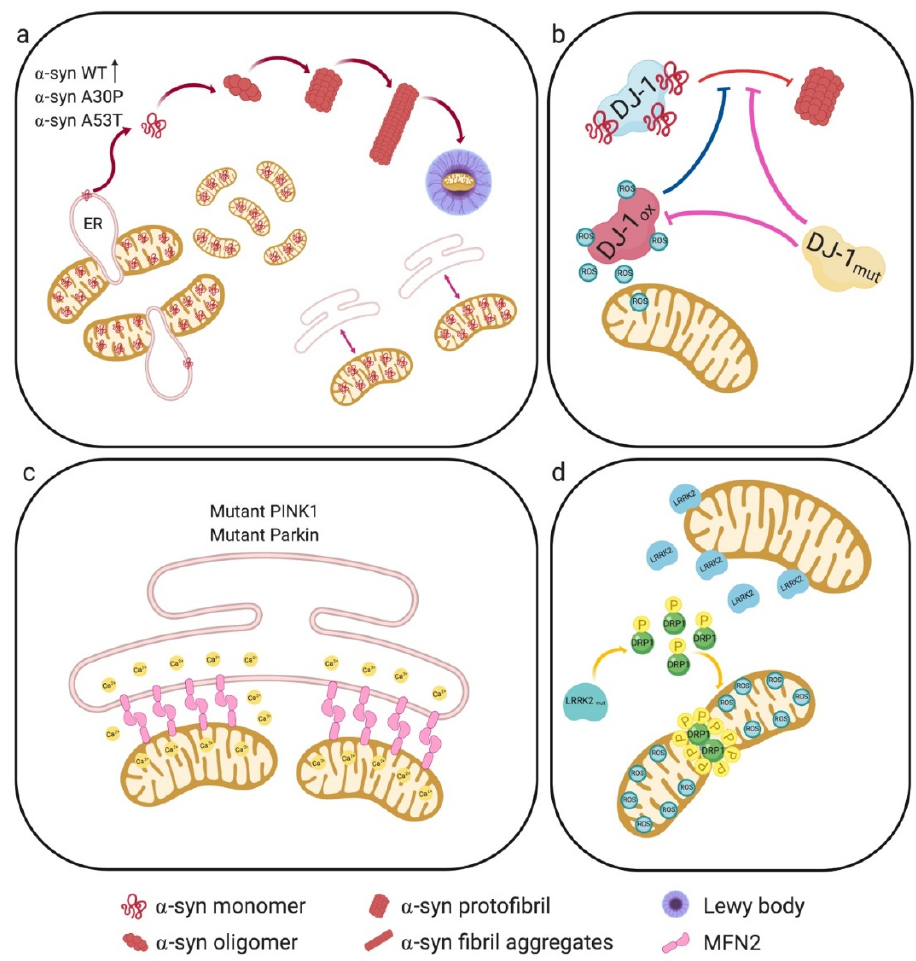
Figure 3. PD-associated genes and their roles in Mitochondria-associated membrane (MAM) structure and function. ( a ) Mutant α -syn results in DRP1-independent mitochondrial fragmentation, reduced MAM-associated mutant α -syn, with a concomitant increase in the pure mitochondrial fraction. This results in reduced ER–mitochondria apposition, leading to impaired interorganellar crosstalk. The A53T mutation makes the protein more prone to aggregation. ( b ) DJ-1 responds to oxidative stress, protecting cells against ROS. DJ-1 interacts with monomeric and oligomeric α -syn, preventing its oligomerization. Under oxidative stress conditions, oxidized DJ-1 is unable to interact with α -syn and to prevent its oligomerization. Likewise, DJ-1 mutations also abrogate its interaction with α -syn and no longer neutralize ROS. ( c ) Mutant PINK1 or Parkin increase ER–mitochondria juxtaposition, resulting in aberrant ER-to-mitochondria Ca 2 + signaling. Furthermore, Parkin dysfunction could lead to increased levels of its substrate MFN2 at MAMs. ( d ) LRRK2 mutations increase its interaction with DRP1, and enhance DRP1 phosphorylation. This results in mitochondrial fragmentation, enhanced ROS, and decreased ATP levels.